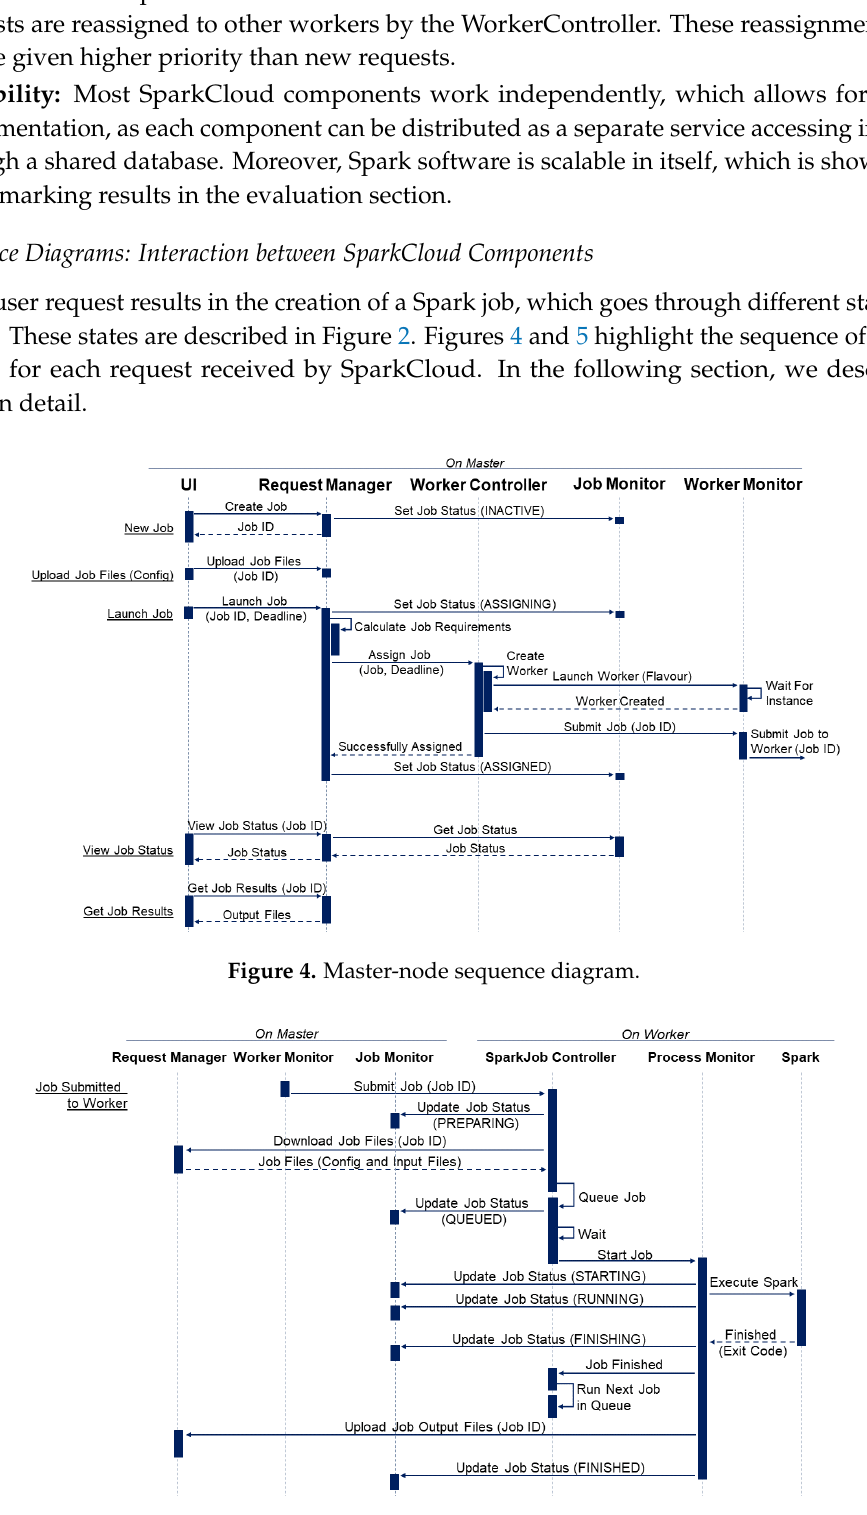
Figure 5. Worker-node sequence